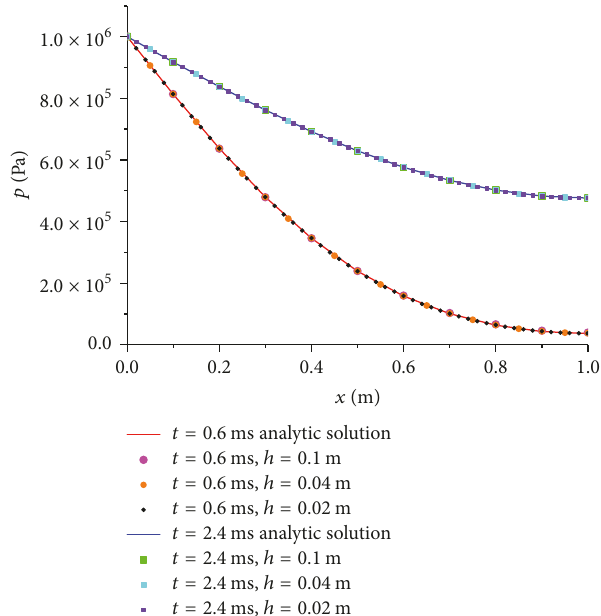
Figure 13: Comparison between analytical and numerical solutions of hydraulic pressure distribution with three sets of